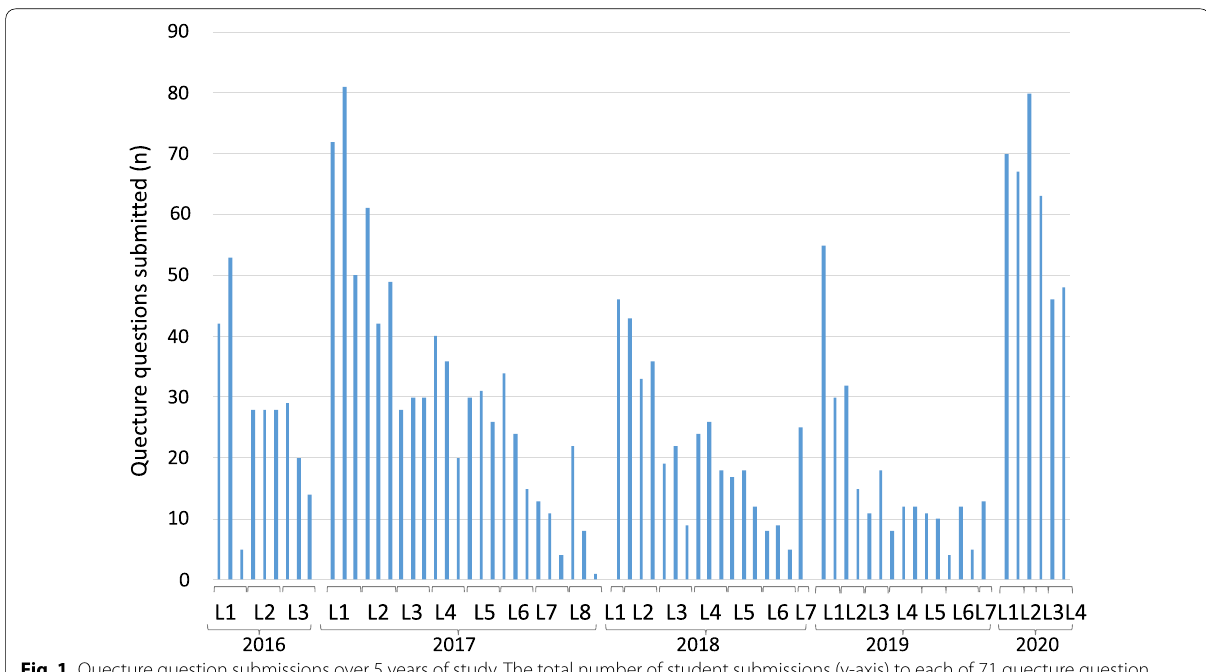
Fig. 1 Quecture question submissions over 5 years of study. The total number of student submissions (y-axis) to each of 71 quecture question interventions (x-axis) over 5 years is shown. The number of lectures (L1–L8) varies between the years, and the number of interventions within each lecture ranges from one to three, dependent on the number of learning objectives. Three quectures given by another instructor in 2020 are not included